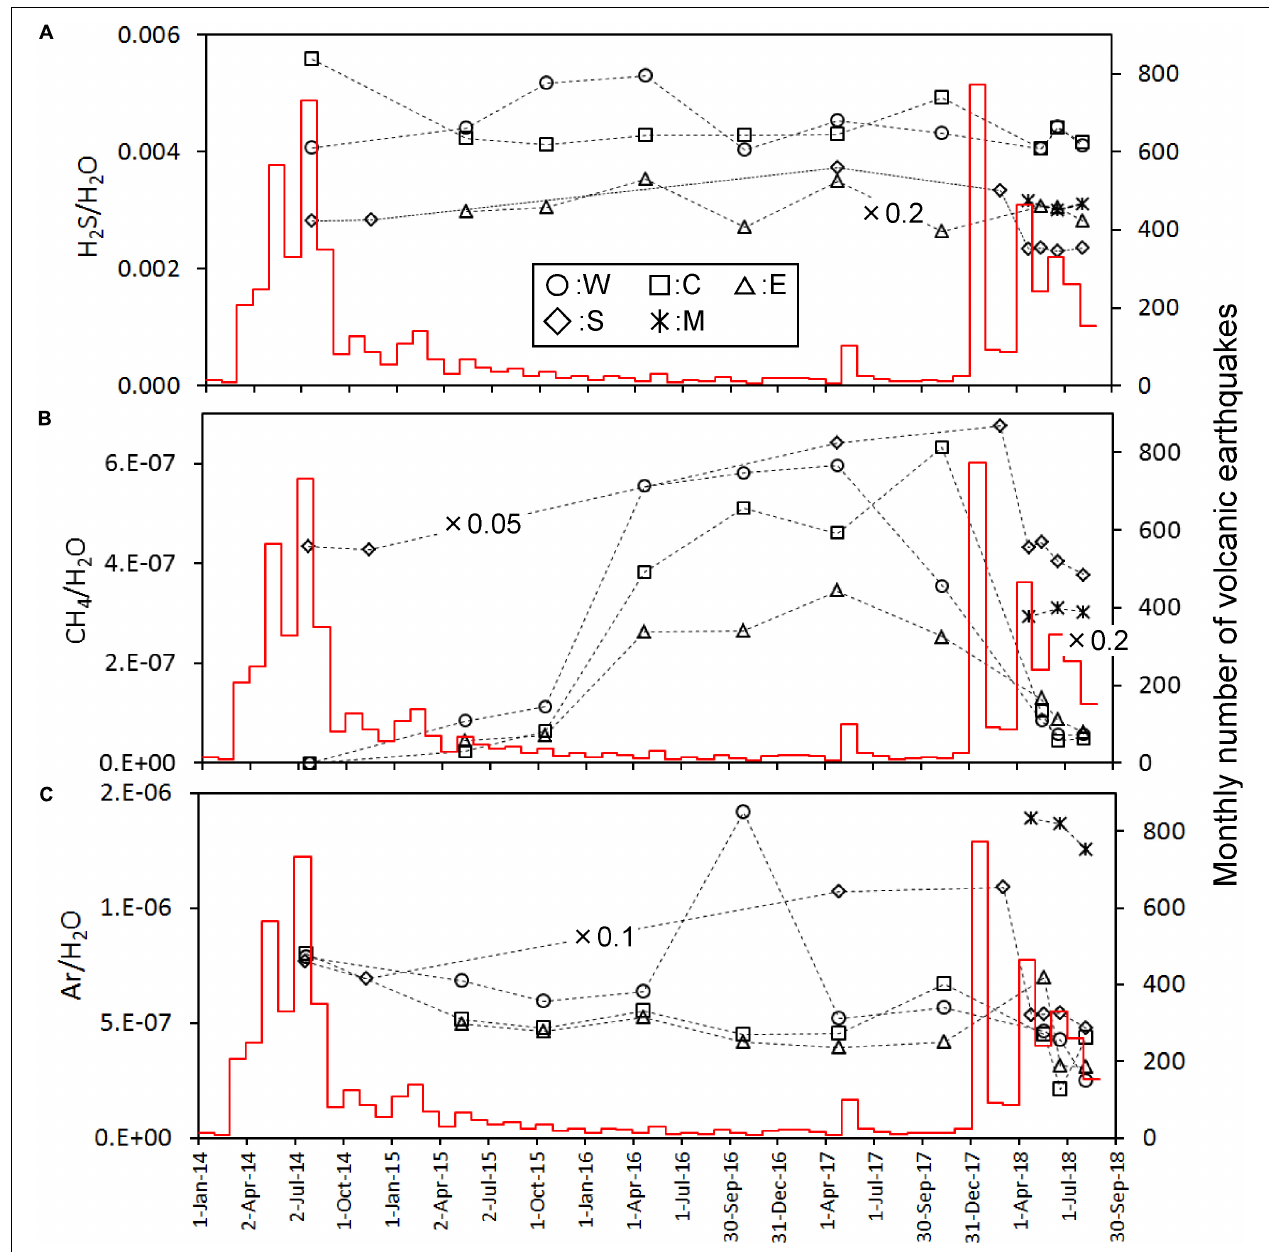
samples a good separation among N 2 , O 2 and Ar peaks was provided. The concentration of Ar in the R-gasses, X Ar was